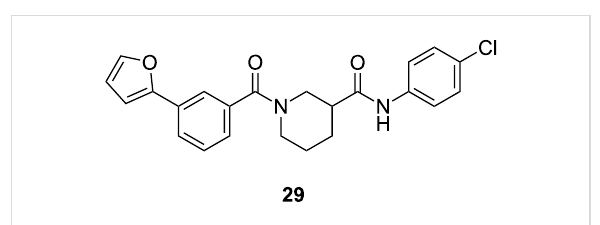
Figure 4: Structure of the competitor used in the photolabeling experi- ment.